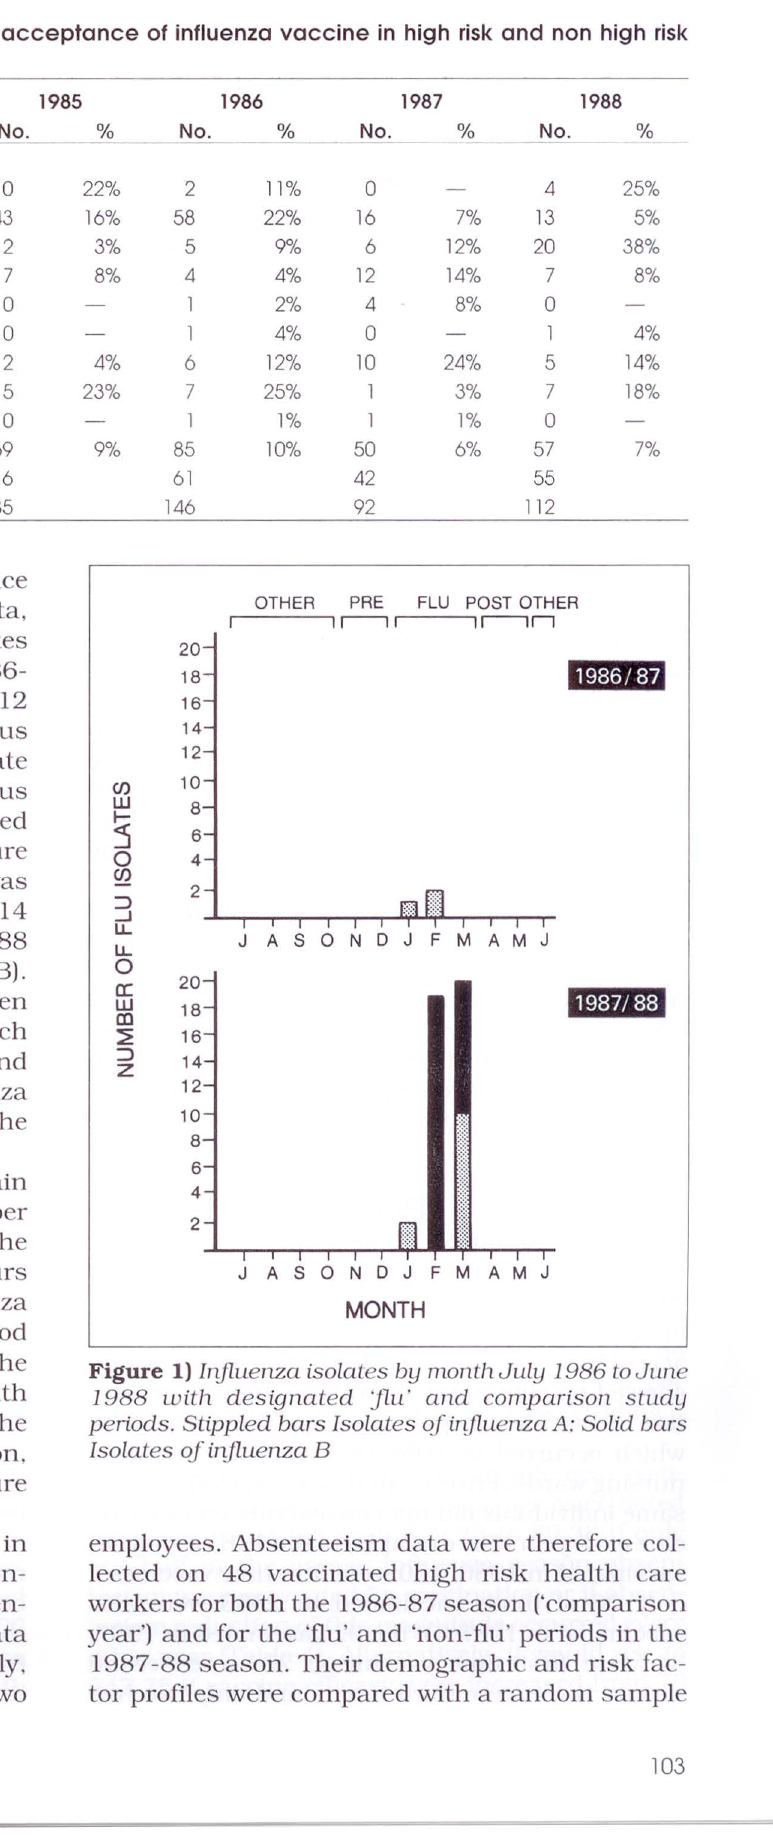
employees. Absenteeism data were therefore col le cted on 48 vaccinated high risk health care workers for both the 1986-87 season ('comparison year') and for the 'flu' and 'non-flu' periods in the 1987-88 season. Their demographic and risk fac tor profiles were compared with a random sample